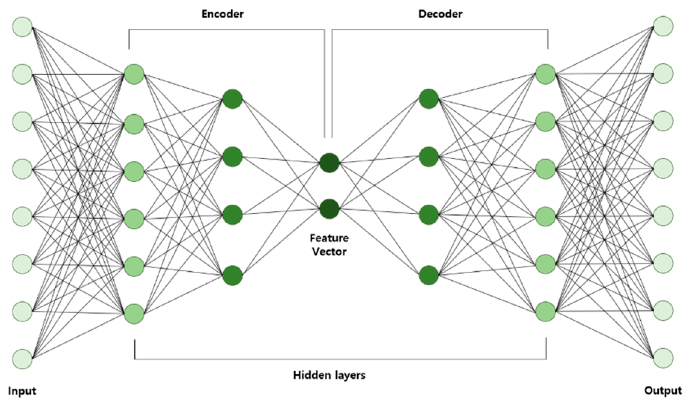
Figure 2. Autoencoder Diagram.